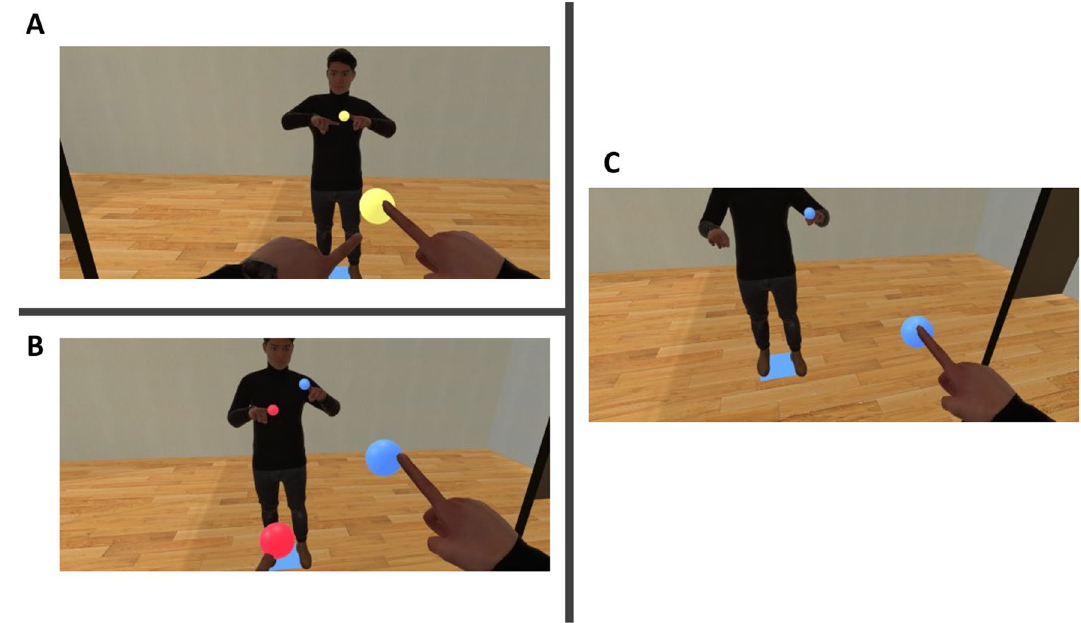
Figure 2. Experiment conditions: ( A ) Same goal condition, where the participants reached one yellow target with both hands of the joint avatar. ( B ) Different goals: Visible condition, where the participants reached red targets with the left hand and blue targets with the right hand of the joint avatar. ( C ) Different goals: Invisible condition, where the participants reached red targets with the left hand and blue targets with the right hand of the joint avatar but were only able to see the targets that could be reached with the hand they could control. Here, only blue targets were visible to the participant controlling the right arm while only red targets were visible to the participant controlling the left arm (image shows the view of the participant controlling the right